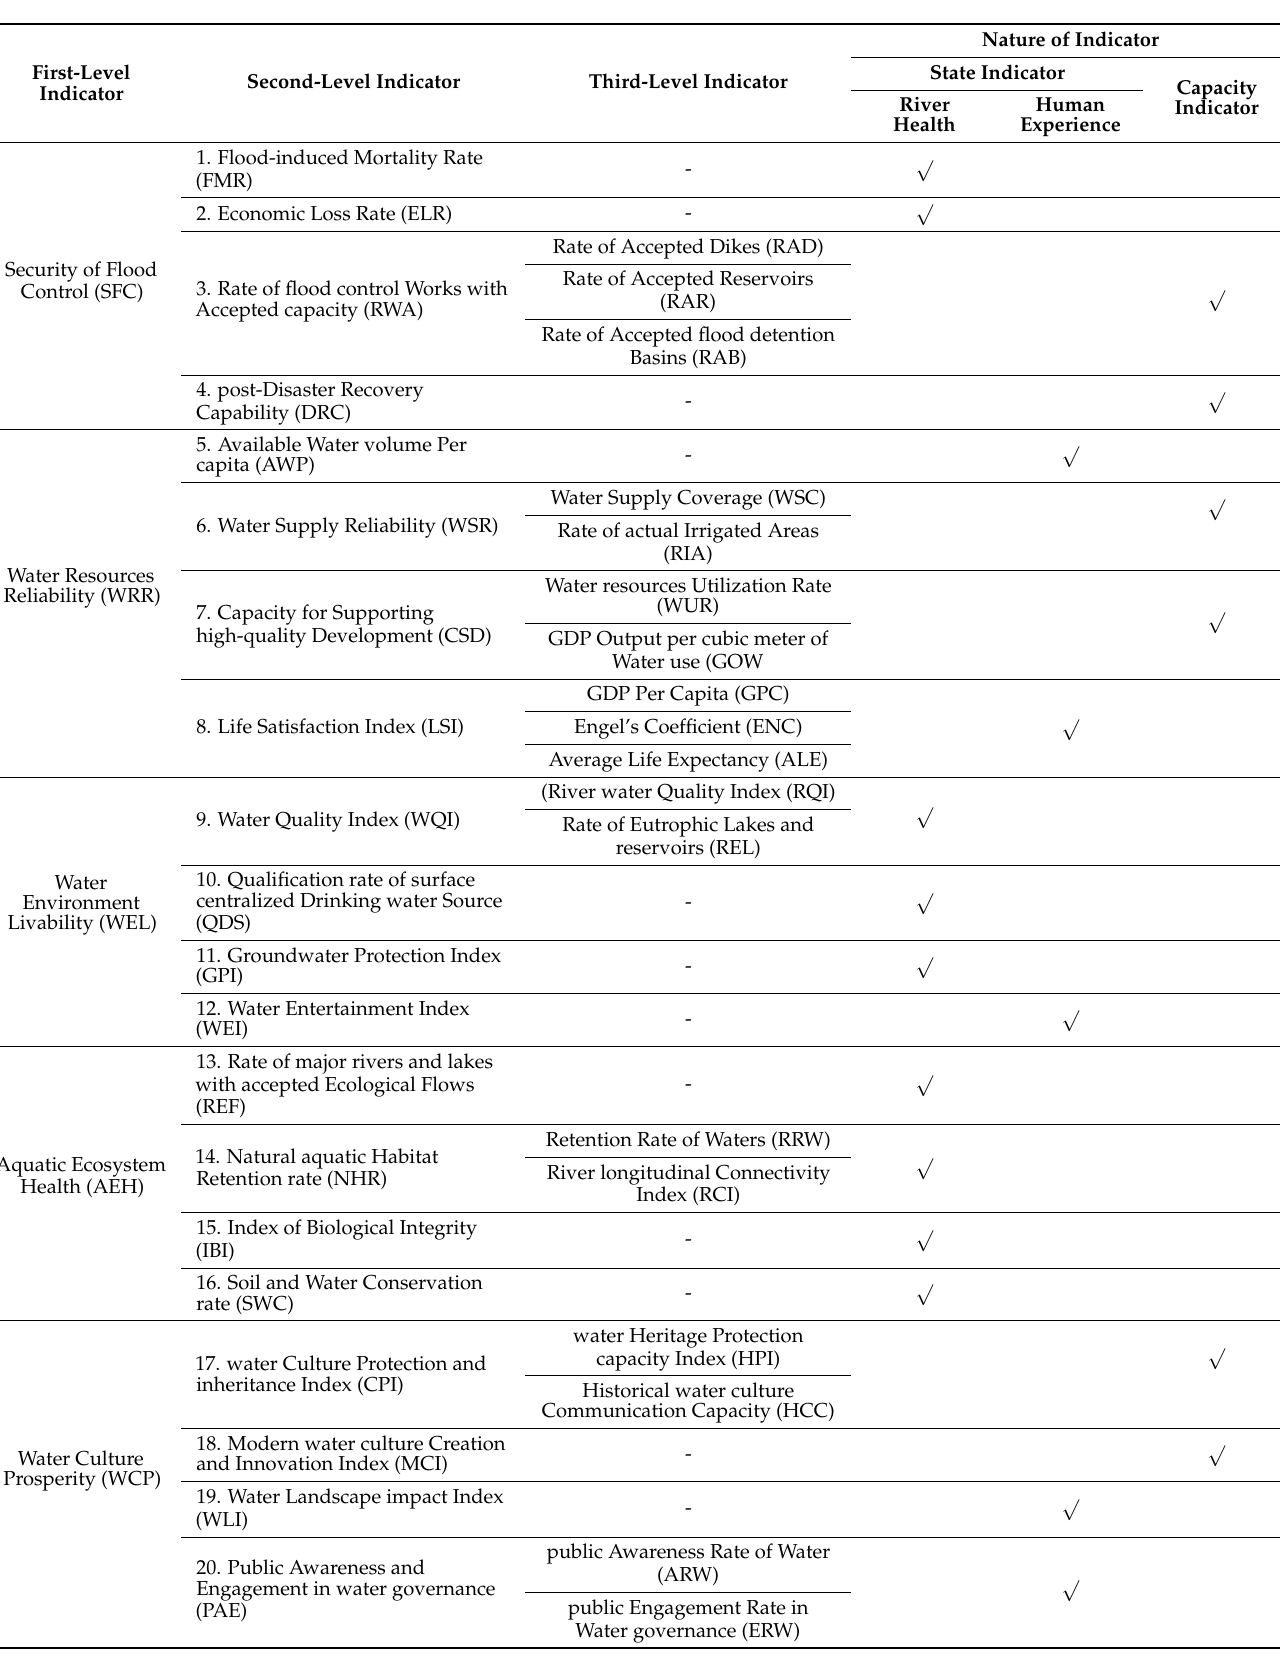
Table 3. Indicator system of the